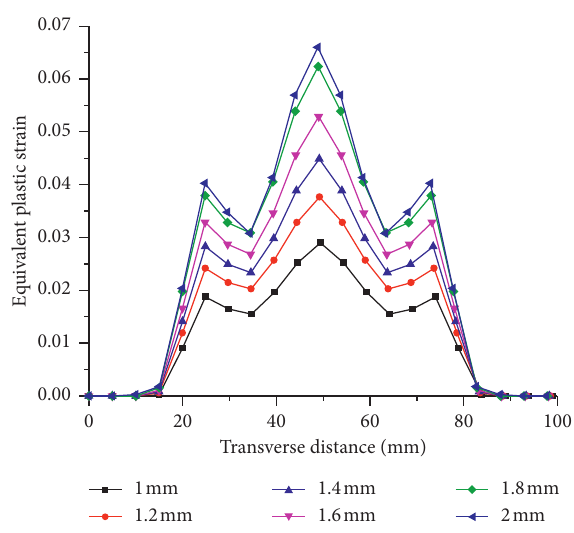
Figure 16: Curves of equivalent plastic strain after springback.